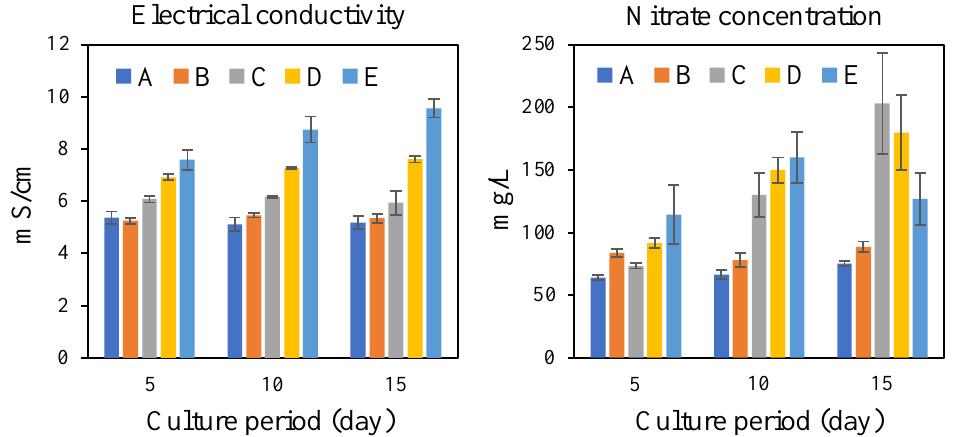
Figure 2. Electrical conductivities (left panel) and concentrations of nitrate (right panel) in runs A, B, C, D, and E. Experiments were performed in triplicate, and error bars represent standard deviations.